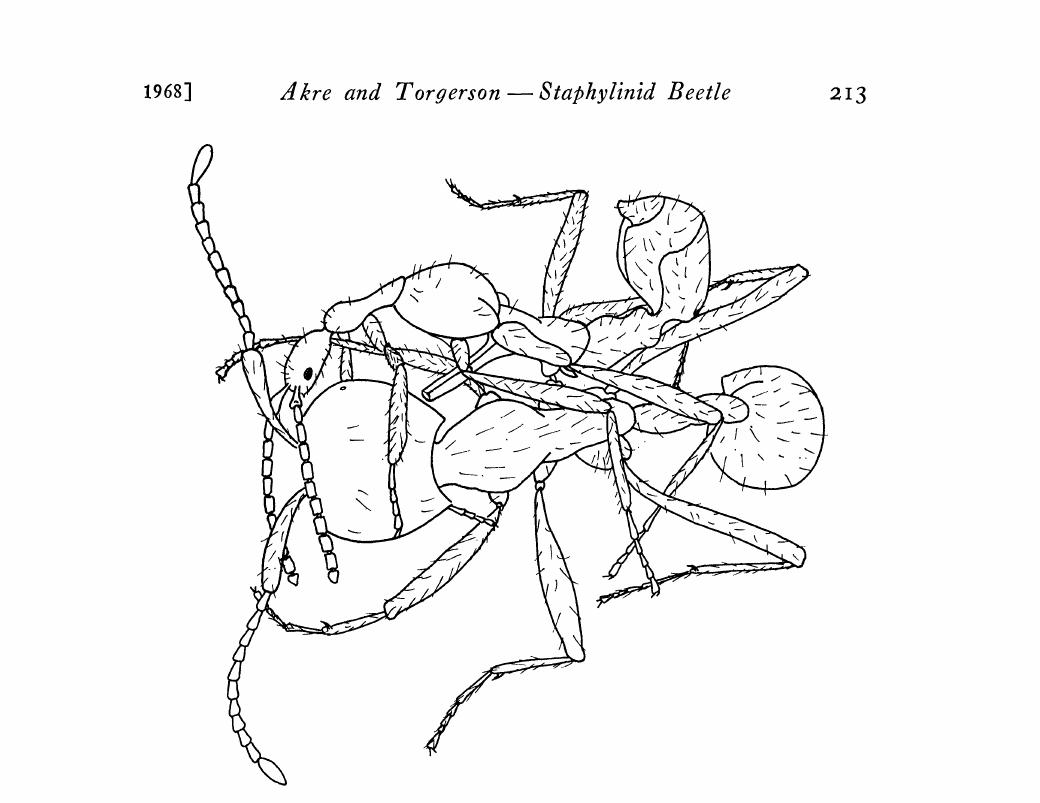
Figure 1. Diploeciton neermanni in its unique grooming position on a worker o its host, N. pilosus. Drawing from a photograph. side of the body to brace against the substrate. The three legs on the other side of the body then straddle the ant. The mesothoracic leg on the bottom curls under and around the thorax of the ant. This places the sternum of the beetle’s thorax against the side o the thorax of the ant as though riding "sidesaddle". In this position the beetle rubs the ant with its legs. The mesothoracic lower leg rubs the bottom of the thorax and the upper legs rub on the dorsal area of the ant; the pro,thoracic leg usually rubs the head of the ant, the mesothoracic leg rubs on the thorax and gaster, while the metathoracic leg is used sparingly to rub the gaster of the ant. The rubbing strokes are rather slow and alternate between stroking the body o the ant and the staphylinid’s own body. The ront leg